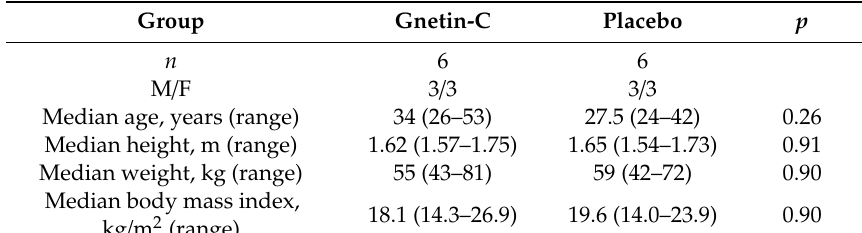
Table 1. Demographic baseline characteristics of the enrolled subjects.